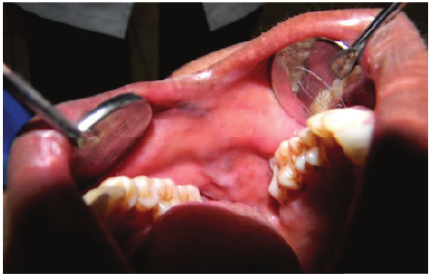
Figure 2: Intraoral right buccal mucosa exhibiting fullness.